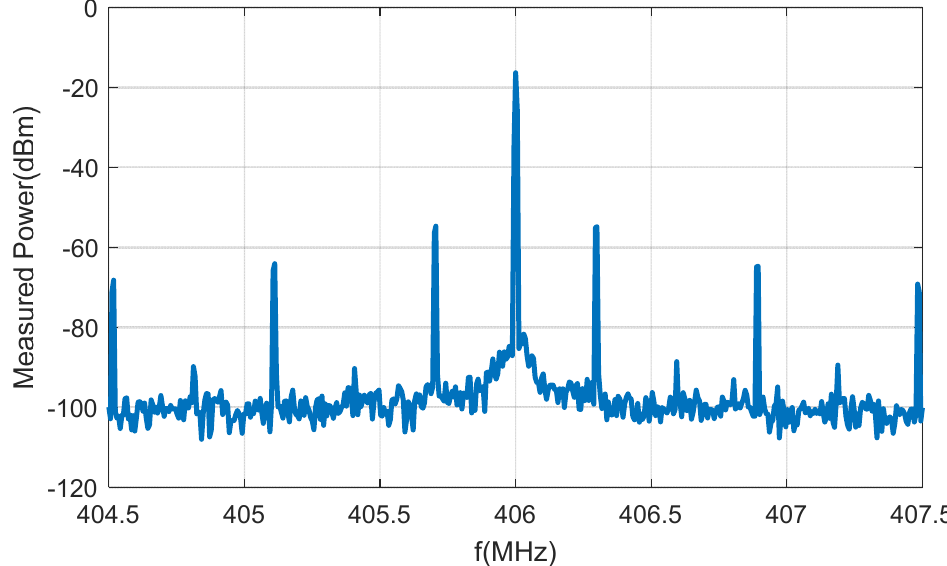
Figure 18. Spectrum of the receiver signal when the backscatter is illuminated at 406 MHz using the setup in Figure 17.